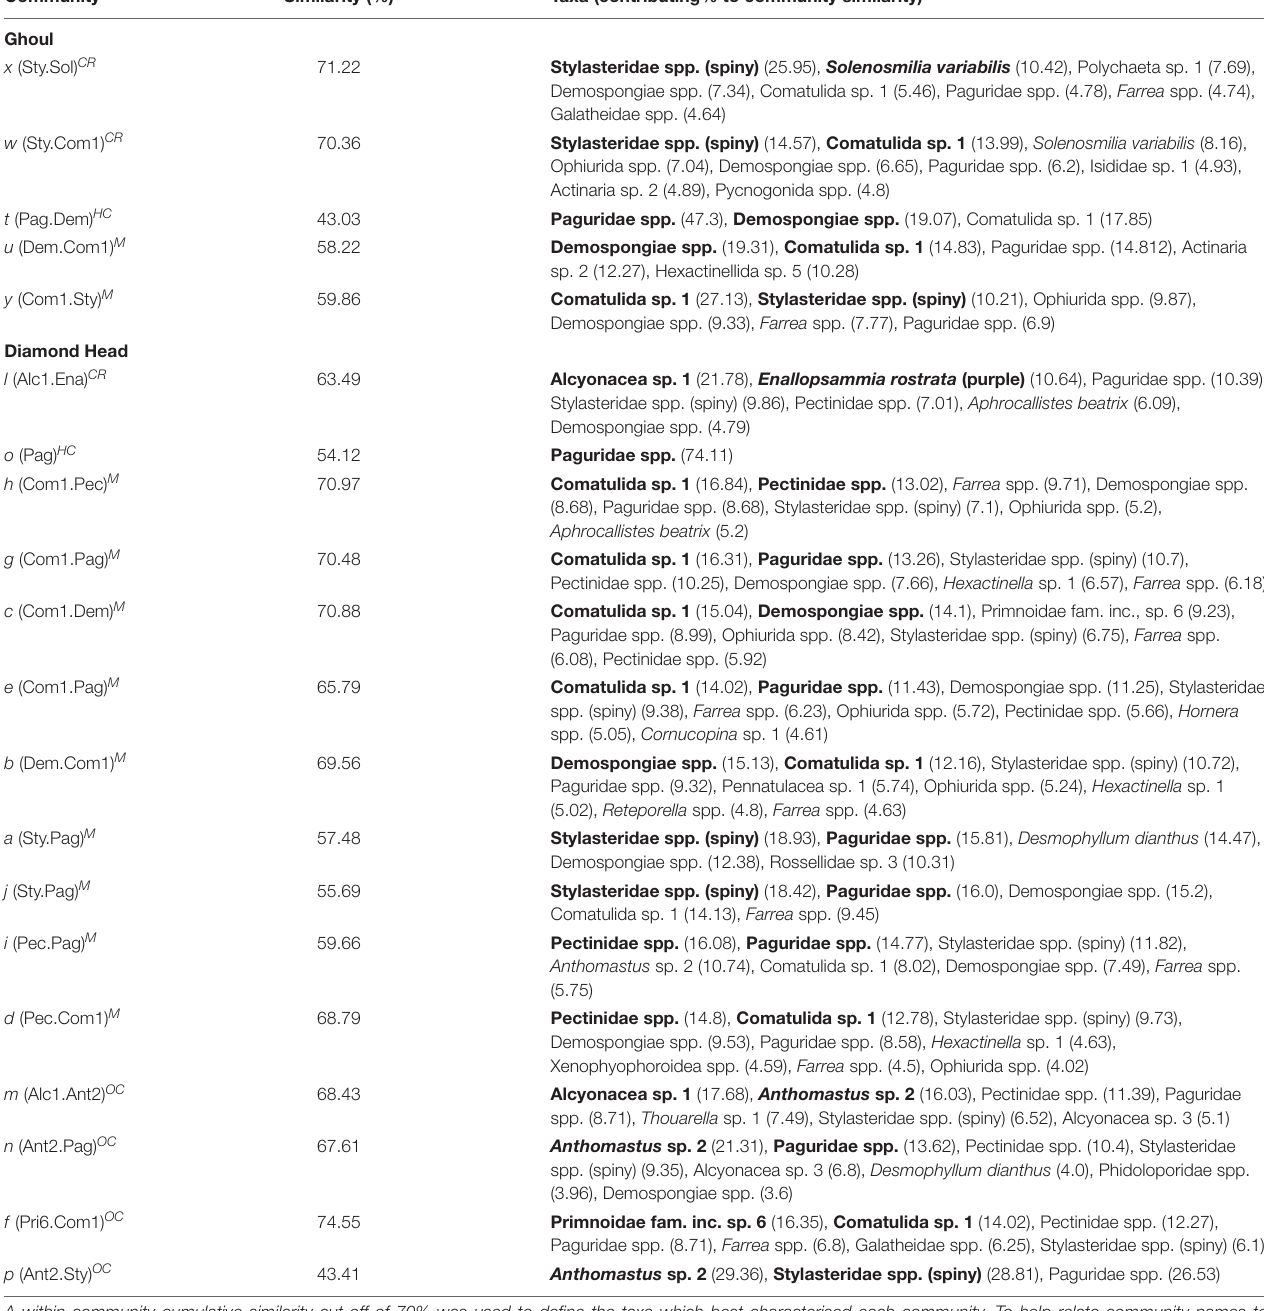
TABLE 2 | Similarity percentage results. Community Similarity (%) Taxa (contributing% to community